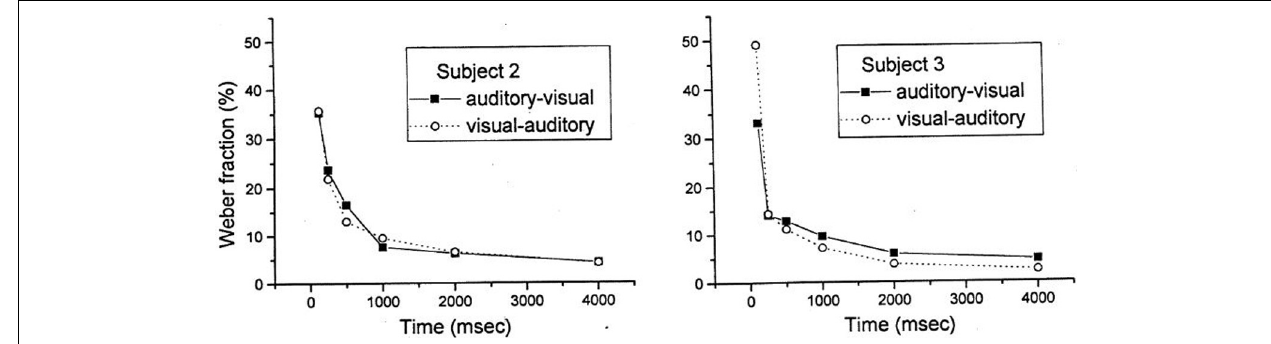
FIGURE 1 | Individual Weber functions for two intermodal conditions of duration discrimination (reported in Grondin, 1996).